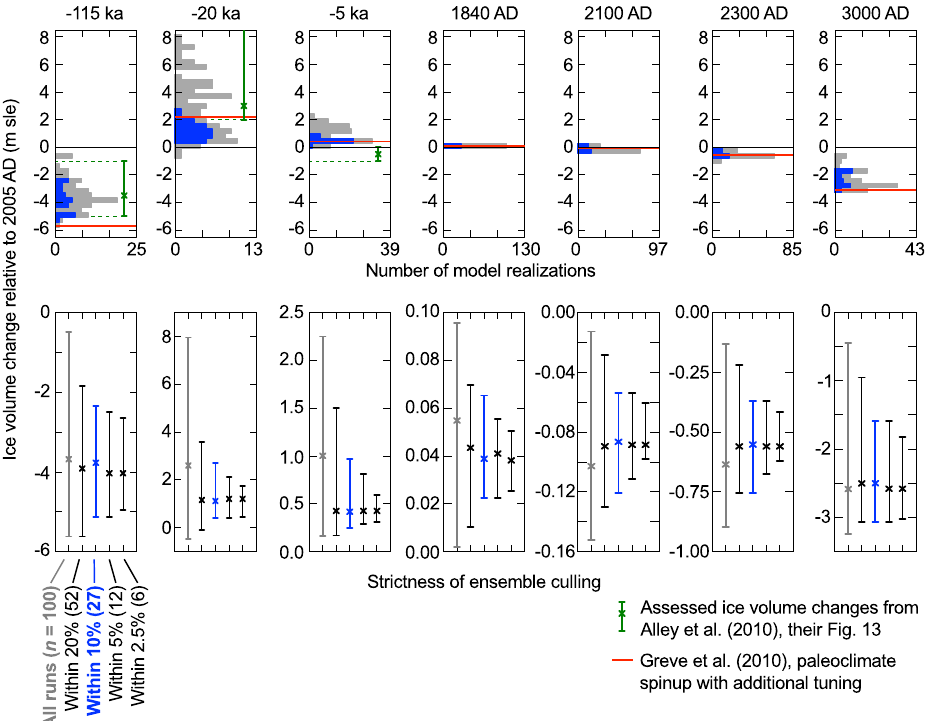
Fig. 4. Histograms of modeled ice volume change relative to 2005 AD (top) and the effects of different assumed uncertainties for the modern ice volume on the median and range of ice volume change projections and hindcasts (bottom). Y -axis scaling is the same for all panels in the top row, but differs among panels in the bottom row. Color coding is the same as in Fig. 2; gray: all model runs; dark blue: model runs that lie within 10% of the estimated modern ice volume in 2005 AD; red line: “paleoclimate spinup with additional tuning” model run from Greve et al. (2011). The green points with error bars in the top panels indicate assessed changes in the ice sheet, relative to the modern, from Alley et al. (2010, their Fig. 13). None of our model runs produce a smaller-than-today ice volume during the mid-Holocene ( − 5ka). For the future time slices (2100, 2300, and 3000 AD), the range of potential future ice volume changes is always at least 40% of the median, regardless of how strictly the ensemble is